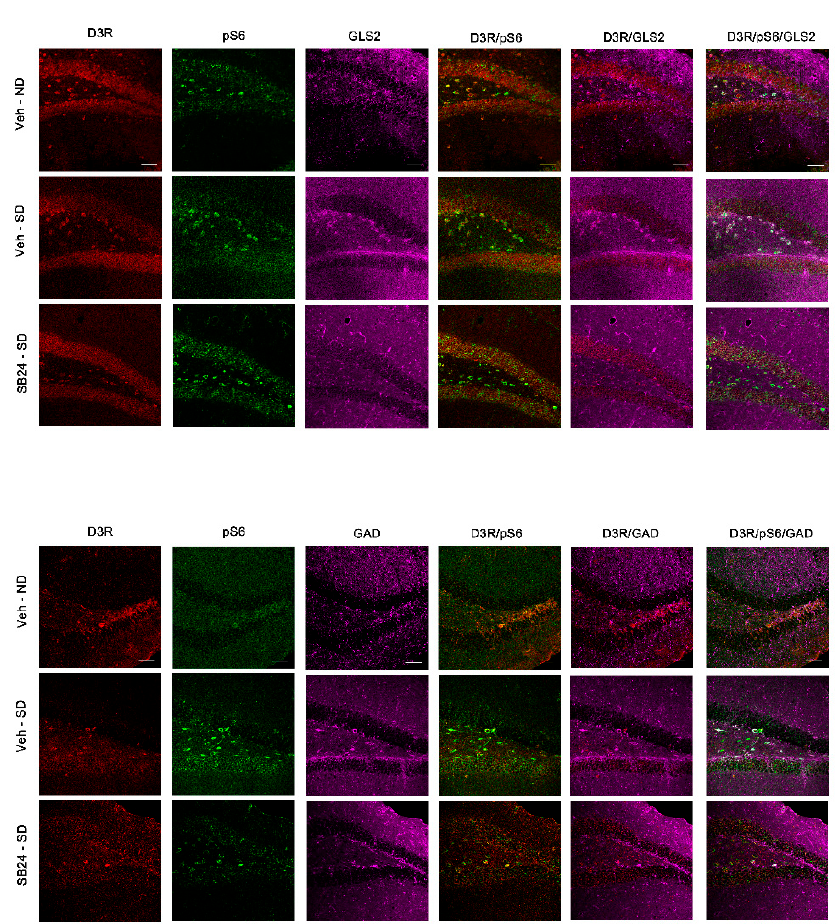
Figure 9. Representative confocal images showing the dentate gyrus coronal sections immunostained for dopamine type 3 receptor (D3DR, red), phosphorylated S6 protein (activated; green), GLS2 (magenta, glutamatergic neurons), and GAD (magenta, GABAergic neurons) from controls (veh-ND), from mice exposed to a social defeat agonistic encounter after 60 days of abstinence (veh-SD) and from mice receiving an injection of the D3DR antagonist SB-277011-A (24 mg/kg i.p.) prior to the social-defeated agonistic encounter after 60 days of abstinence (SB24-SD). Colocalization of D3DR/GLS2, pS6/GLS2, DRD3/pS6/GLS2, D3DR/GAD, pS6/GAD, and DRD3/pS6/GAD are also shown in the figure. Scale bars: 50 μ m.